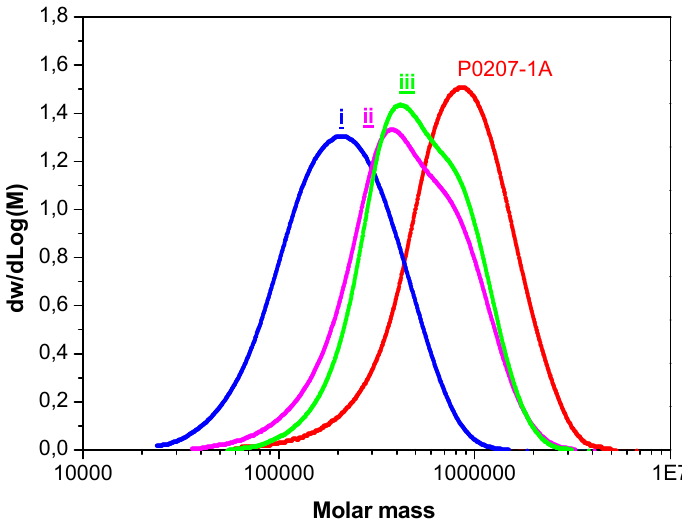
Figure 4. Comparison of differential MMD (molar mass distribution) of four biopolymeric